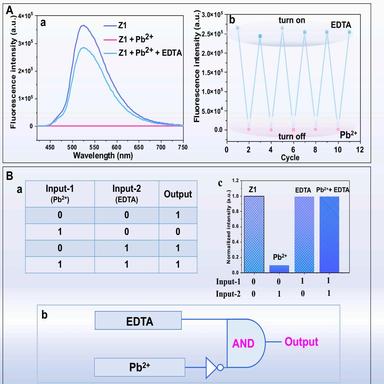
Reversibility and logical gate of Z1 + Pb2+. A. (a) Fluorescence emission spectra of Z1, Z1 + Pb2+ and Z1 + Pb2++EDTA. (b) Reversibility of Z1 + Pb2+ with EDTA. B. (a) Truth table of one-to-two logic devices. (b) Logic gate diagram. (c) Truth table change of one-to-two logic devices.